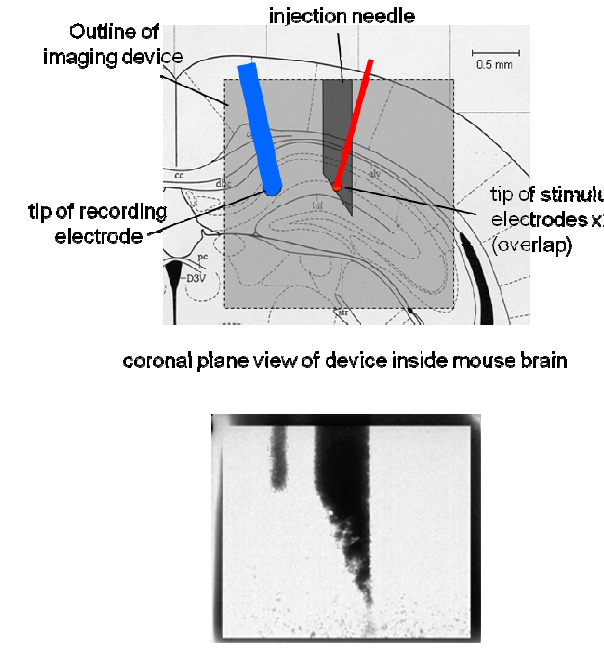
Figure 18. Experimental setup of measuring neural activity in the mouse